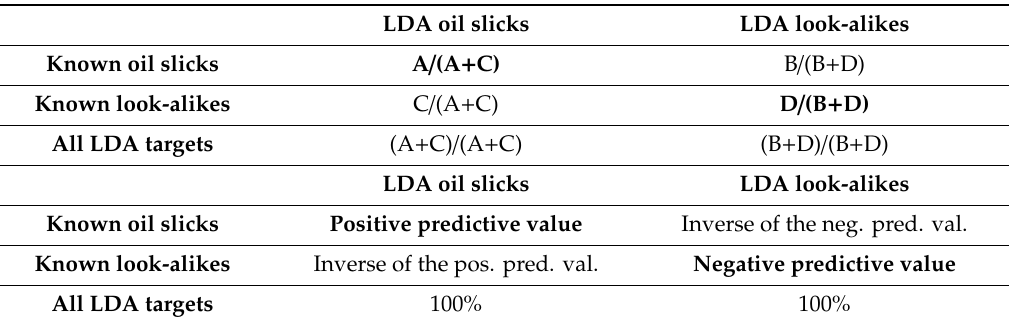
Table 3. “Vertical” analysis of the confusion matrix shown in Table 1 with some of the associated metrics used to evaluate our Linear Discriminant Analyses (LDAs).